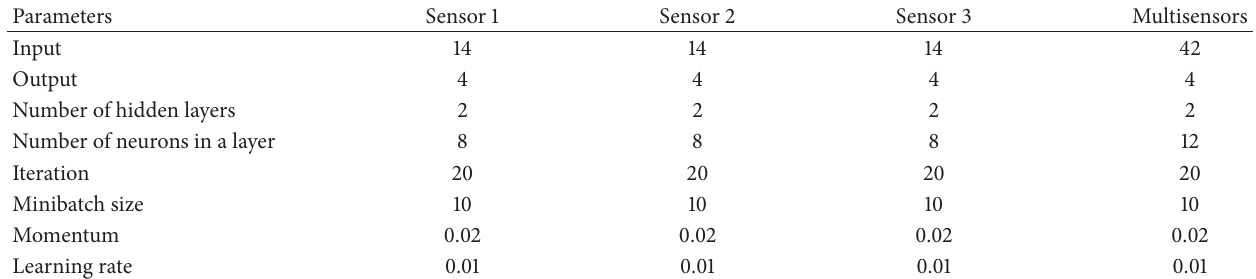
Table 4: The parameters of DBN in sensors 1–3 and multisensors.